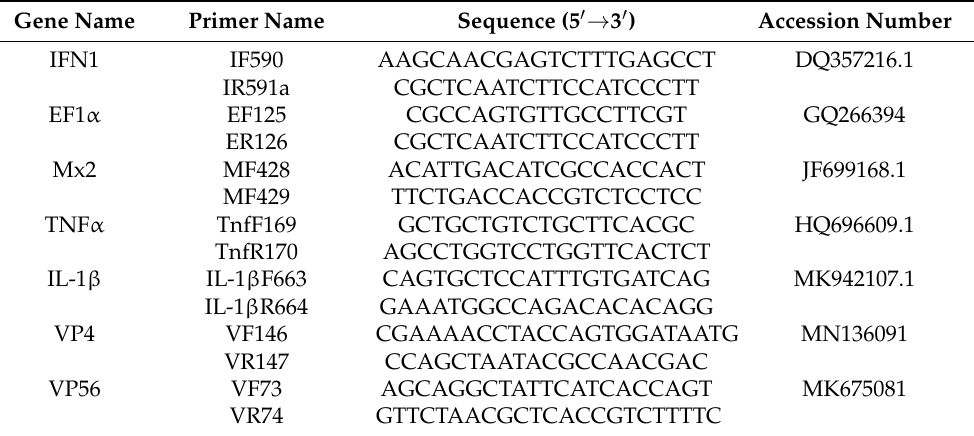
Table 1. Primer sequences used for quantitative real-time polymerase chain reaction (qRT-PCR) analysis in this